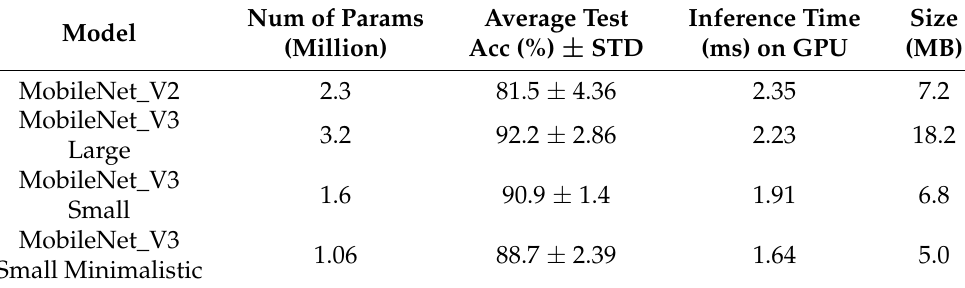
Table 4. Results over the four different